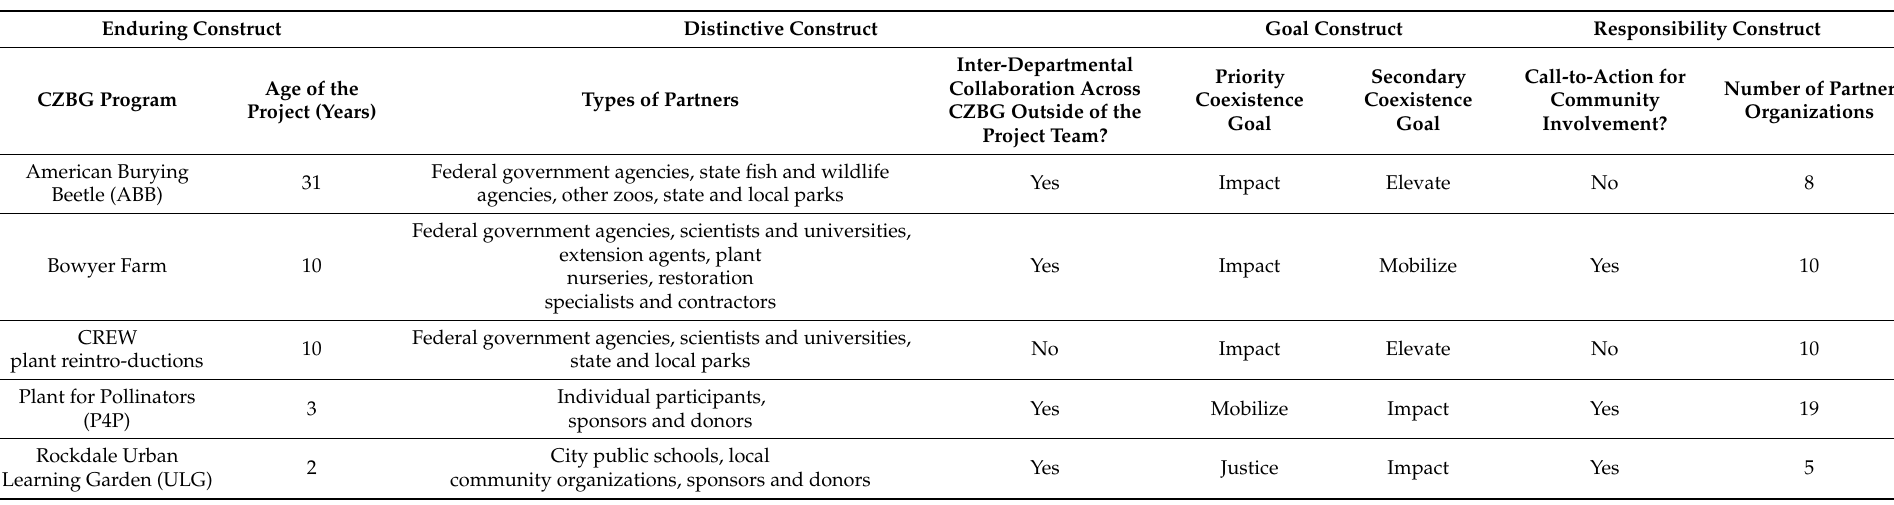
Table 1. Program details for the five case studies representing the enduring, distinctive, goal, and responsibility constructs from